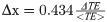
Competence and twitching phenotypes of null mutations.All data in this figure were taken using complex media and incubating at 37°C. Both competence and twitching assays were performed on agar: 1.5% for competence and 0.5% for twitching. Color scheme is the same as Fig 1. Like symbols indicate that genes are part of the same operon. All data points contain multiple measurements for both competence and twitching. Error bars represent the standard deviation of multiple measurements. For the x-axis standard deviation is given by Δx=0.434ΔTE<TE> where x = log <TE> and ΔTE is defined as the standard deviation from the mean transformation efficiency, <TE>. The detection limit for competence is 10−9 and for twitching is 0.4. Data points that fall below either detection limit appear on the graph in a “below detection limit” region. Their position within this region has no physical interpretation beyond indicating that they fall below this limit.